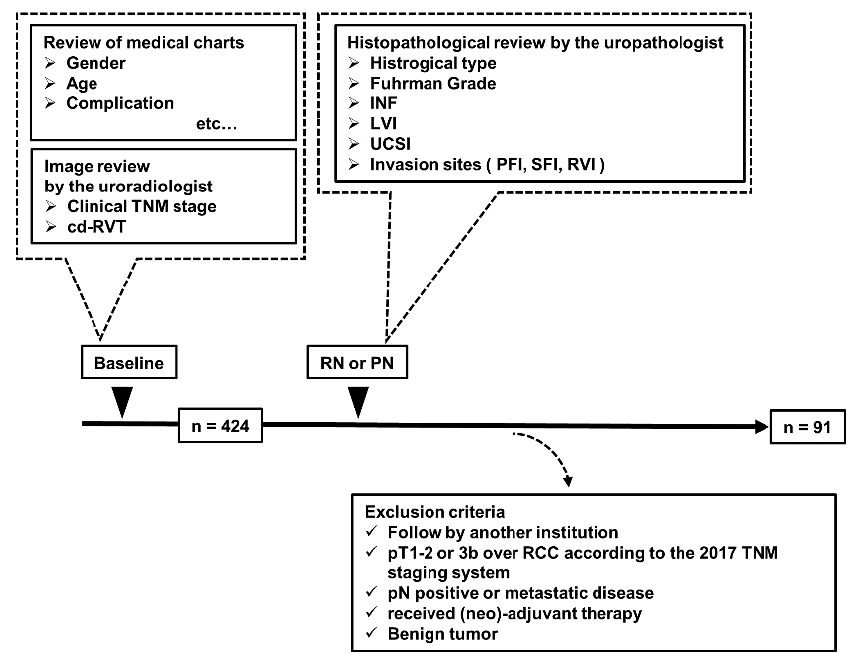
Figure 1. Schematic representation of the study workflow This study included 424 patients who underwent unilateral RN or PN for RCC at our institute between 2007 and 2017. Of these, 91 patients with pT3aN0M0 RCC were identified. Information regarding the preoperative conditions was obtained retrospectively by reviewing the medical records and laboratory blood tests. Data on gender, age, comorbidities, and C-reactive protein were obtained. Preoperative imaging evaluation and TNM classification including the presence or absence of cd-RVT were performed by a skilled uro-radiologist. The operation was performed by skilled urologists at our hospital. Postoperative sample evaluation was performed by a pathologist specializing in the urology. After establishing the exclusion criteria, 91 cases were identified. cd-RVT, clinically detected renal vein thrombus; INF, infiltration; LVI,